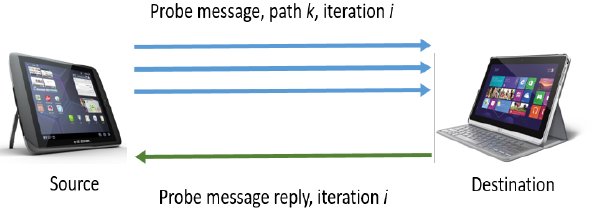
Figure 2. Probe message (PM) packets periodically flooded from source to destination. Probe message reply (PMR) packets gather QoS feedback about the available paths k found in iteration i